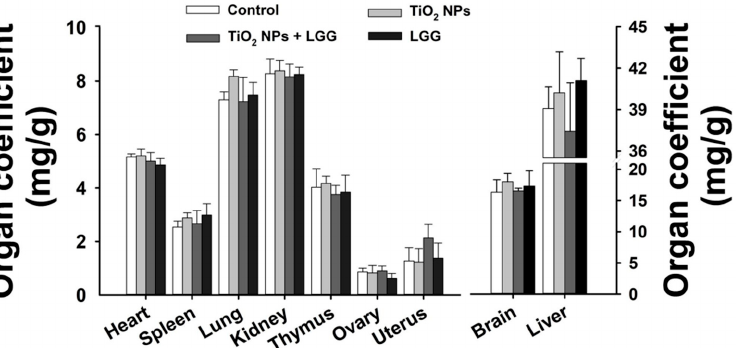
Figure 3. Organ coefficient in the young rats after exposure TiO 2 NPs. n = 6, values are presented as mean ± SD.